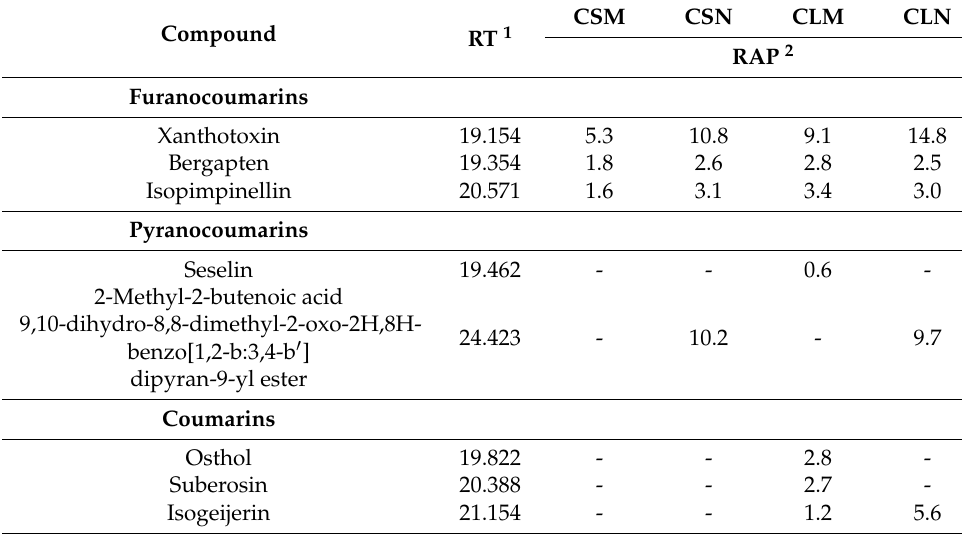
Table 2. Phytochemical composition of Cachrys spp.